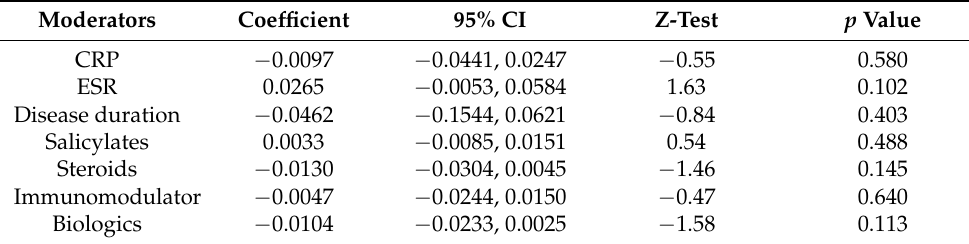
Table 3. Random-effects meta-regression of